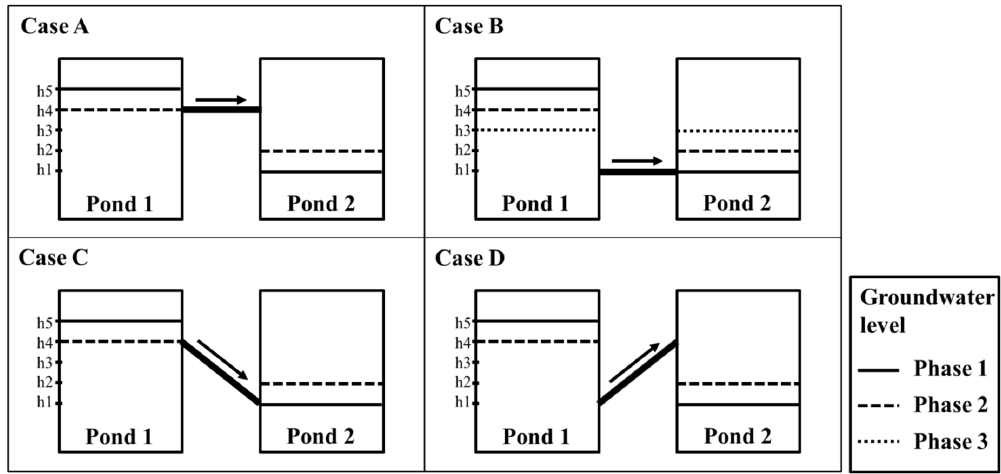
Figure 1. Schematic diagram of the simplified model in SIMPL (Simplified groundwater program In Mine workings using the Pipe equation and Lumped parameter model) showing the groundwater flow through each pipe type.